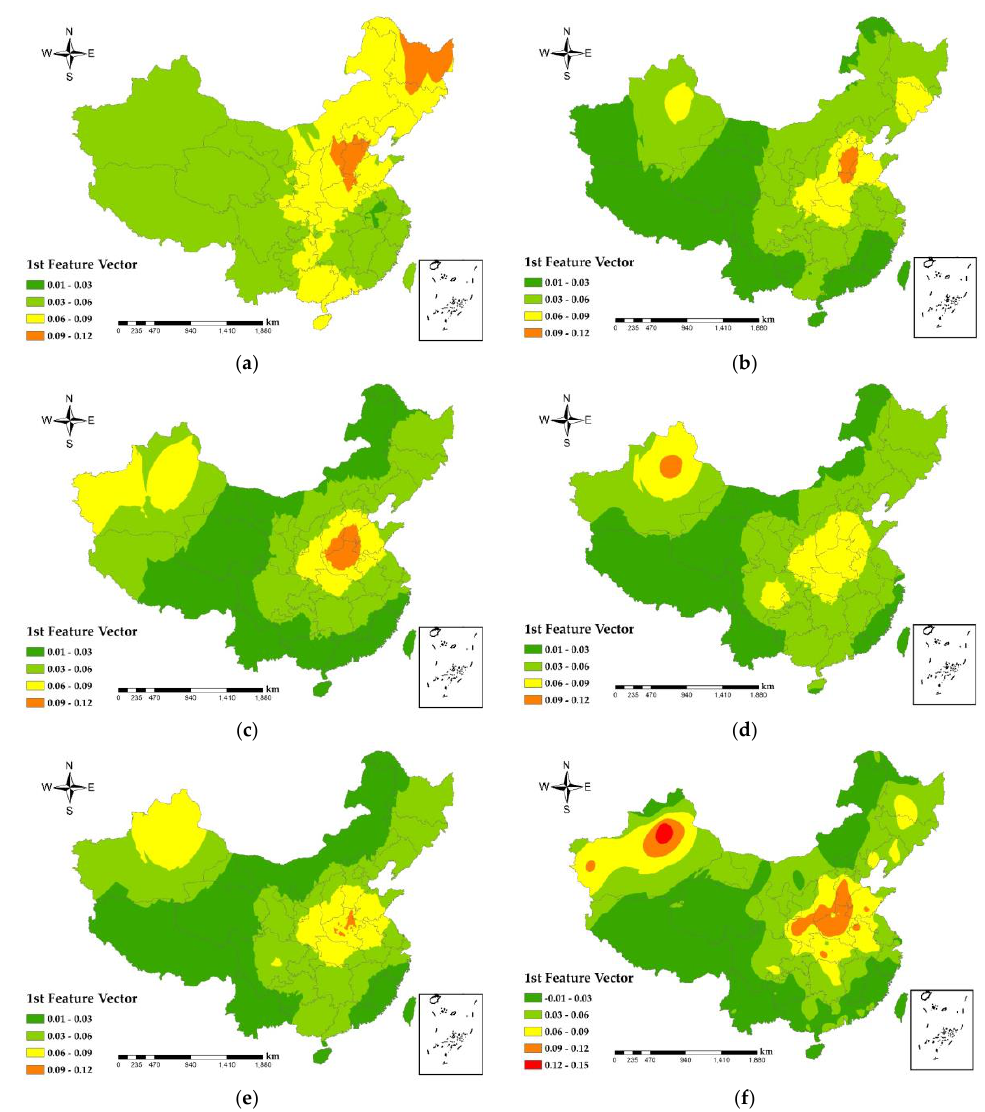
Figure 4. Spatial distribution of the first feature vector of monthly PM 2.5 concentration during 2014–2019. ( a ) 2014; ( b ) 2015; ( c ) 2016; ( d ) 2017; ( e ) 2018; and ( f ) 2019.